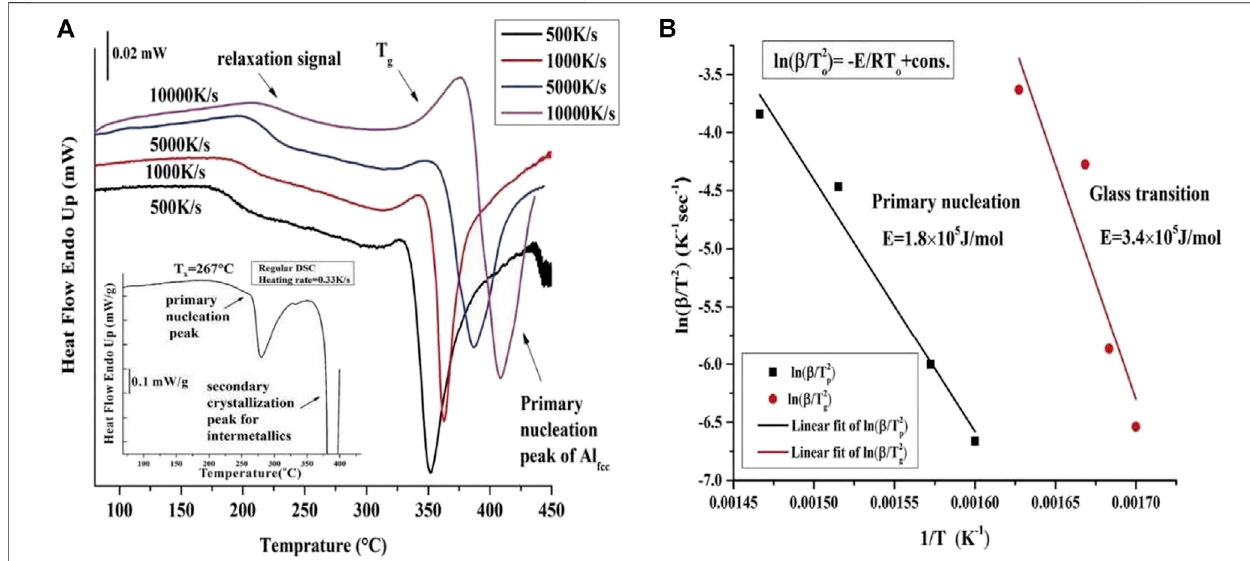
FIGURE 2 | (A) Experimentally measured Flash DSC heat fl ow curves for Al 88 Y 7 Fe 5 MG with four different heating rates of 500, 1,000, 5,000 and 10,000 K/s. The inserted plot gives the conventional DSC heat fl ow curve and the heating rate is 0.33 K/s. (B) The Kissinger plots for glass transition temperature Tg and the primary crystallization temperature Tp with different heating rates (from Shen et al.